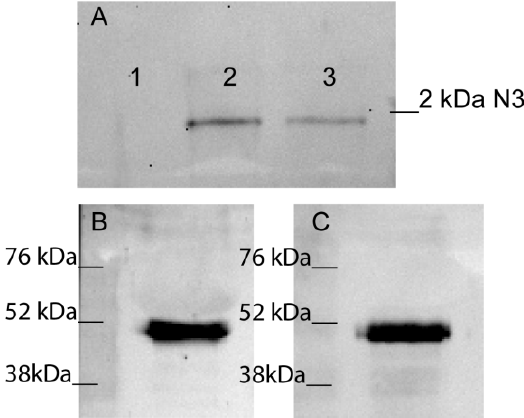
Figure 2. N3 peptide binds to TREM-1. ( A ) Elution of biotin-N3 peptide from sTREM-1 conjugated with CNBr-activated sepharose. 1—washing before elution, 2—elution of N3 peptide, 3—control N3 peptide. ( B , C ) Crosslinking N3 peptide with TREM-1 on monocytes surface. Binding N3 peptide with TREM-1 on monocytes surface in presence of BS 3 . Cells were lysed and purified with anti- TREM-1 Dynabeads ( B ) or anti-Tag7 Dynabeads ( C ). Bound material was analyzed by SDS-PAGE followed by WB and detected with anti-Tag7 ( B ) and anti-TREM-1 ( C ) respectively.